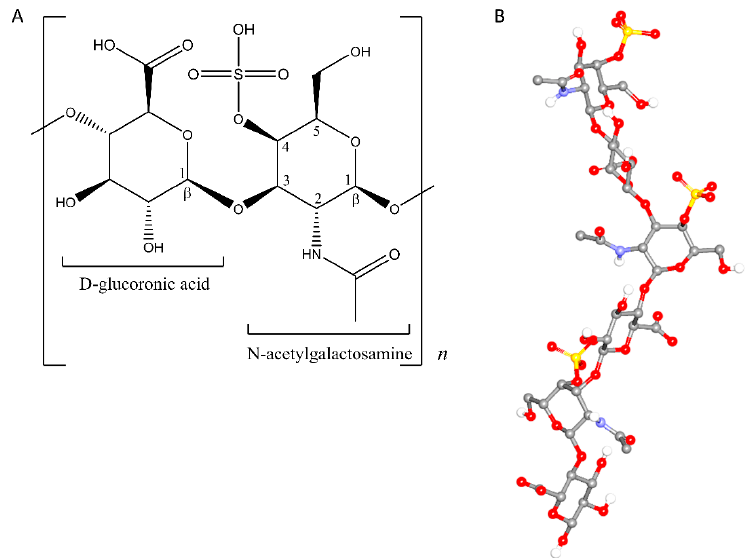
Figure 1. Repeating unit of chondroitin sulfate A (CSA): 2-D monomer ( A ) and 3-D helical repre- sentation consisting of three monomer units, extracted from its crystal structure entry 4N8W [20] ( B